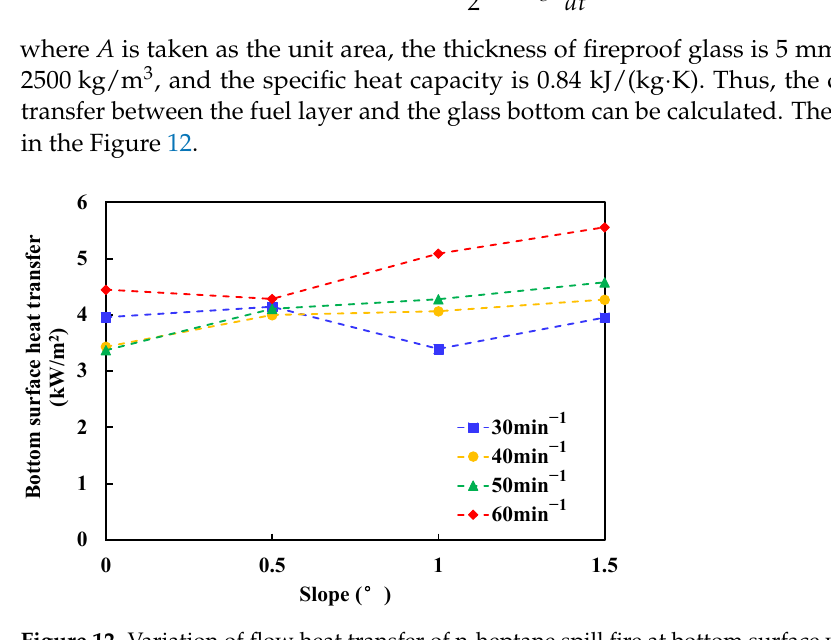
Figure 12. Variation of flow heat transfer of n-heptane spill fire at bottom surface with slope.